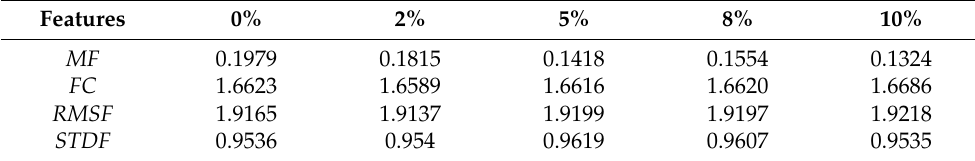
Table 2. Features of the surge velocity signal in the frequency domain for different fault